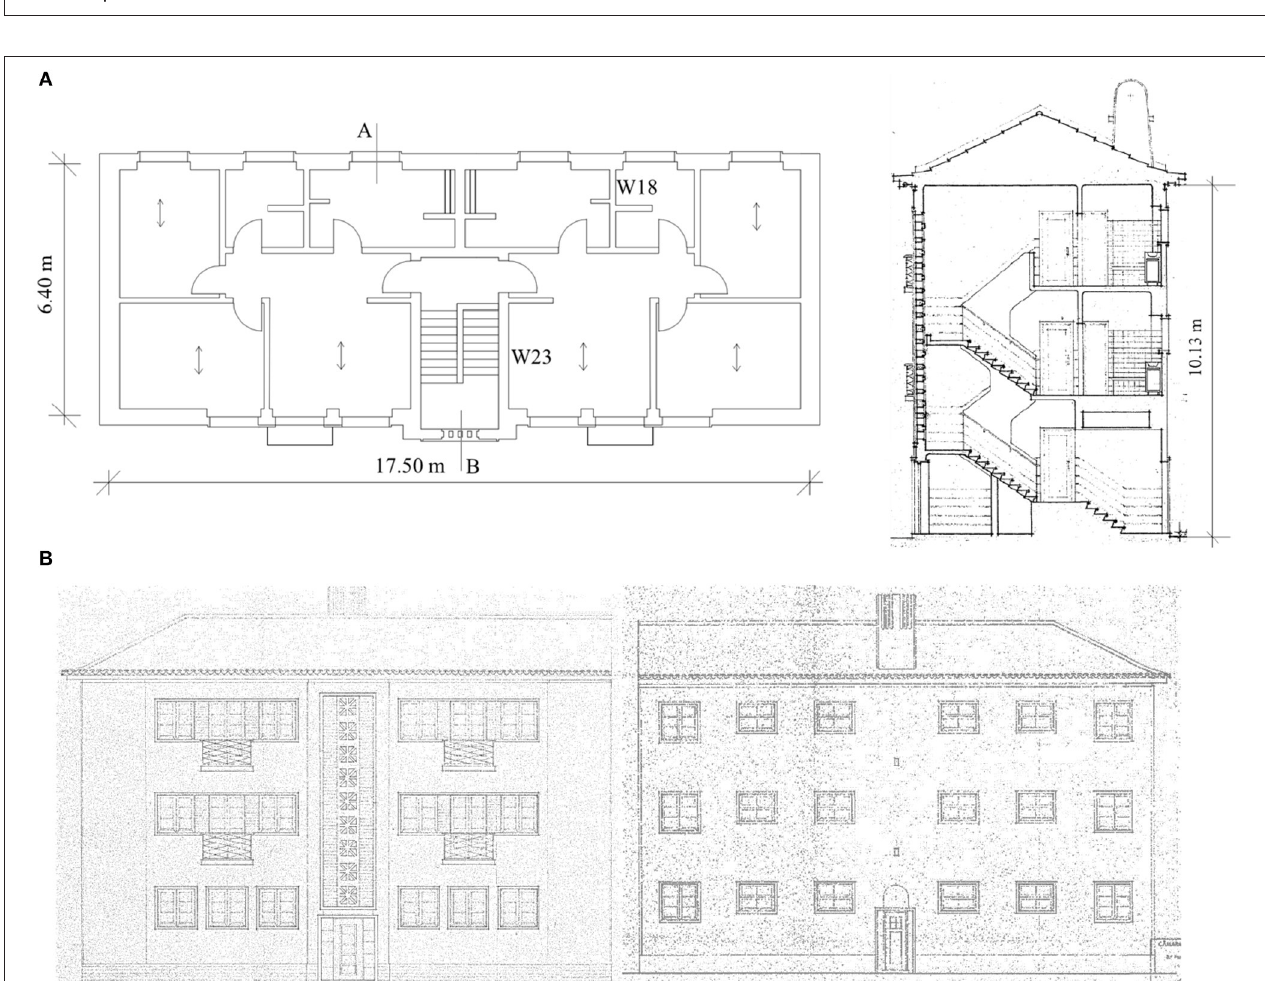
FIGURE 8 | Drawing of the case study. (A) plan and cut section “AB” (right) of the building. (B) front (left) and back (right) fascades.